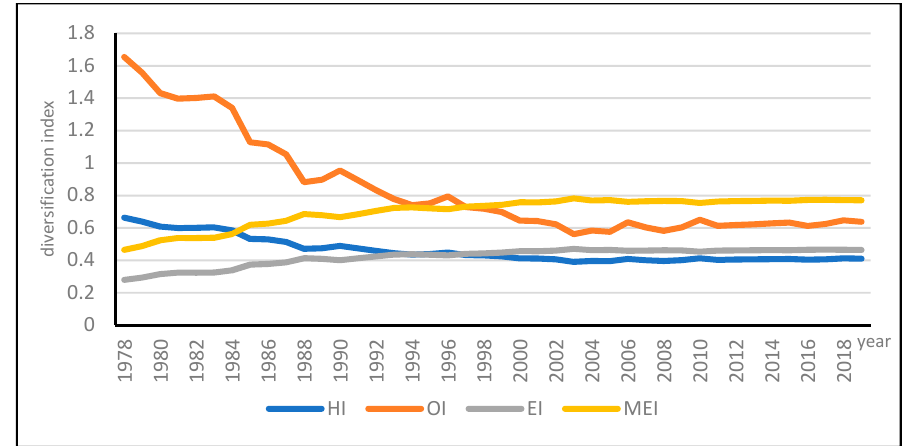
Figure 2. Different measurements of agriculture diversification.